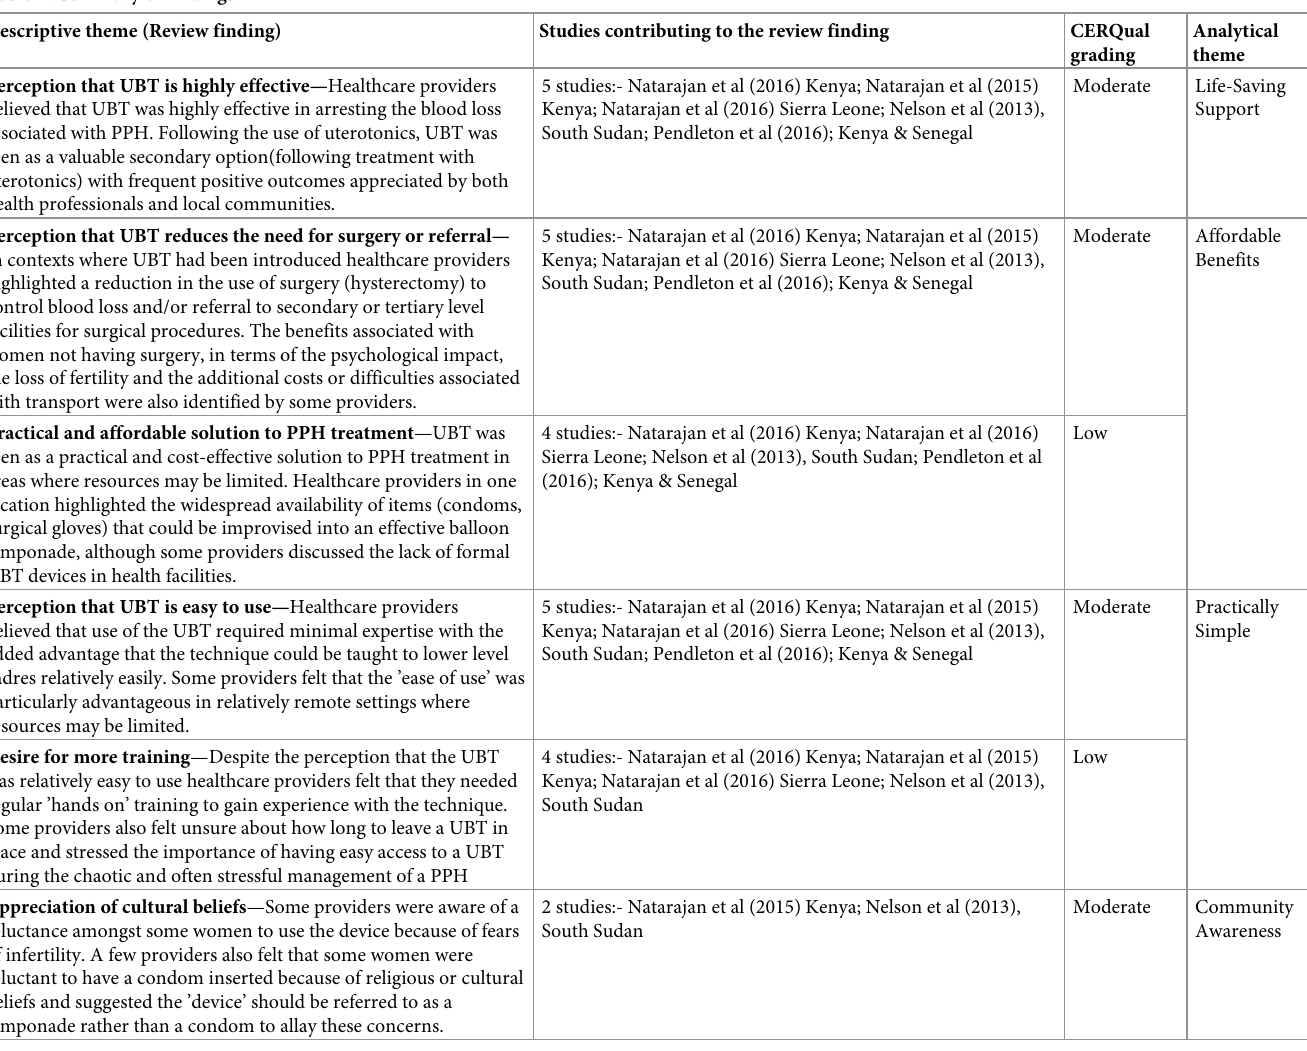
Table 2. Summary of